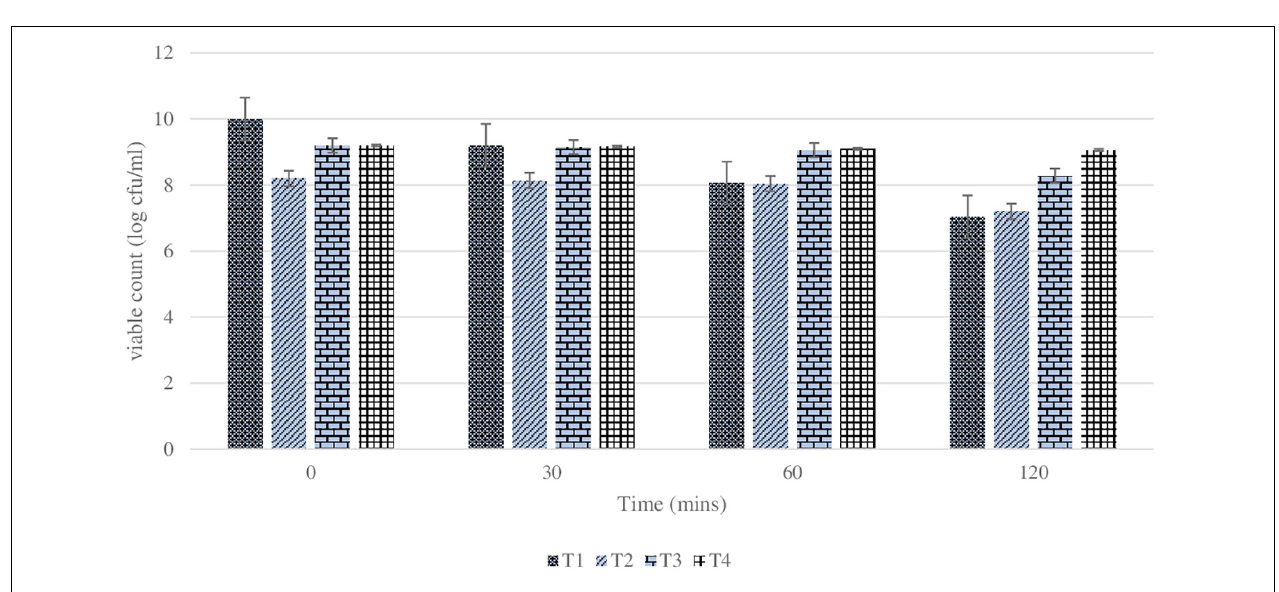
FIGURE 2 | Microscopic photos of (A) uncoated cell and (B) LbL coated cells after gram staining. The coated cells were noticed to have clear areas around them as shown by arrows while uncoated cells were representing typical gram-stained bacteria.